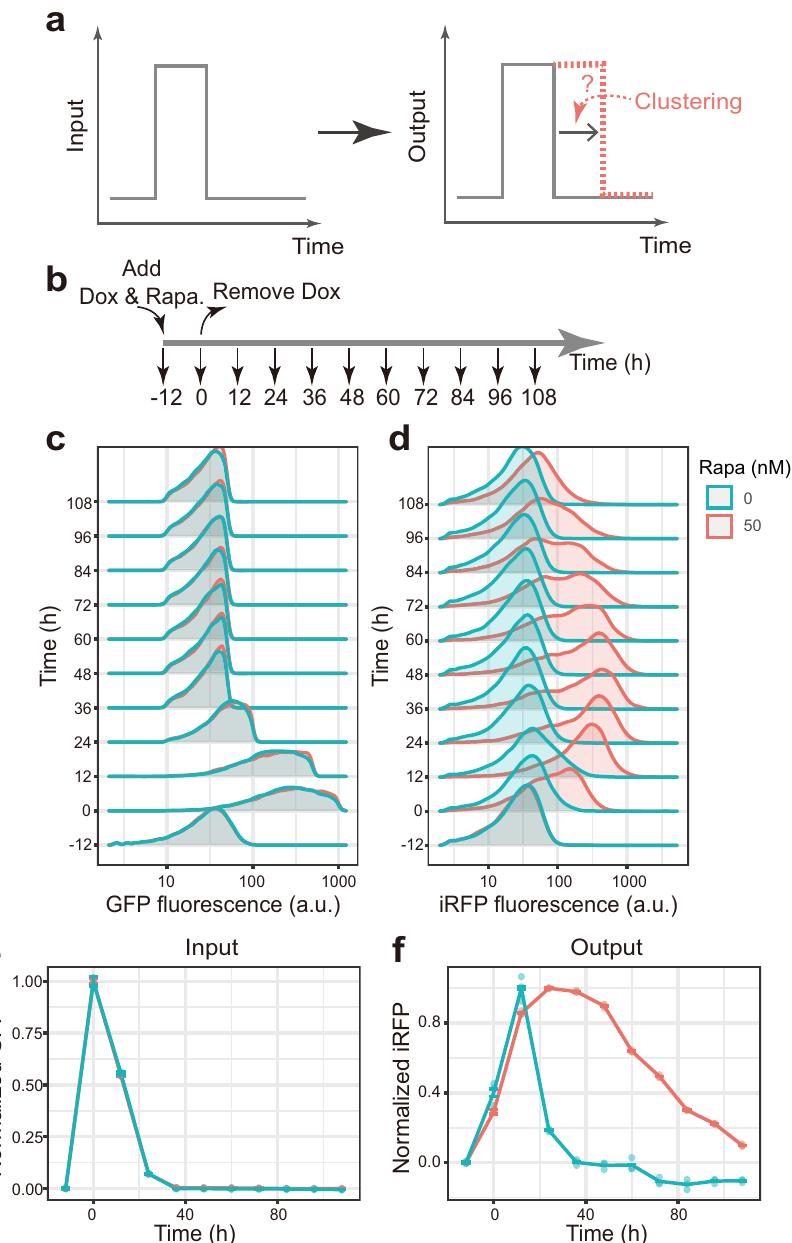
Fig. 5 TF clustering confers sustained transcriptional response to transient stimuli. a Assay design. b - d , TF clustering results in a sustained temporal response of the target gene. CHO-Gal4 cells were subjected to a transient doxycycline (0.1 μ g/mL) treatment, which induced the expression of the synthetic TF, Gal4-VP64. Both the TF and the reporter fl uorescence levels were then quanti fi ed by fl ow cytometry at indicated time points ( b ). Rapamycin (50 nM) was present or absent throughout the time course. The TF levels display a transient increase for both conditions ( c ), whereas the reporter levels exhibit distinct behaviors between the two conditions ( d ). Note that we gated the TF intensity to ensure comparable input levels. See Supplementary Fig. 7a for ungated results. Data from three biological replicates were pooled together for ( c , d ), with each replicate behaving similarly. e – f Normalized input ( e ) and output ( f ) traces showing that while the input signals between the two conditions are almost identical, the output signal displays a sustained transcriptional response when TF clustering propensity is high (50 nM rapamycin). Data are presented as mean ± S.D. ( n = 3 biological replicates). See Supplementary Fig. 7b, c for ungated results. Source data are To detect potential sustained response behavior, we compared similar temporal pro fi les (Fig. 5e, Supplementary Fig. 7b). In the temporal input – output relationships between the two contrast, the output trajectories are drastically different between different rapamycin conditions. By plotting the normalized input the two conditions (Fig. 5f, Supplementary Fig. 7c). More trajectories (i.e., normalized mean TF signals over time) and the speci fi cally, when the TF clustering propensity is high (i.e., at normalized output trajectories (i.e., normalized mean reporter 50 nM rapamycin), the reporter signal decays much slower signals), we found that an input pulse was successfully compared to the condition without rapamycin (Fig. 5f). To test synthesized for both conditions, and the two input pulses share whether the sustained response indeed occurs at the level of